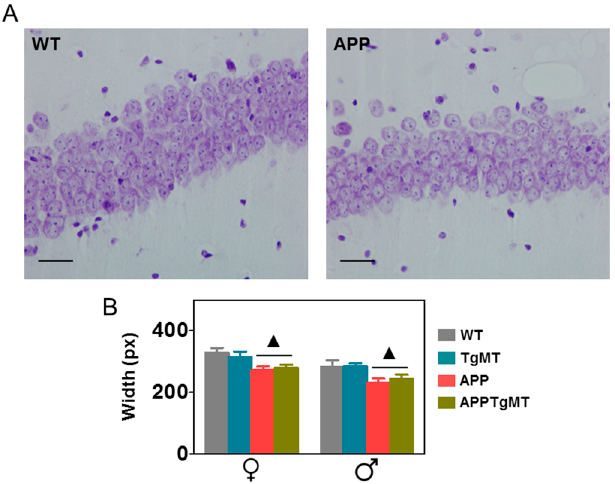
Figure 5. Effect of Mt1 overexpression on hippocampal CA1 neurons. ( A ) Representative histochemistry of Nissl body staining of neurons in hippocampal CA1 of WT and APPWT mice. Scale bar: 20 µm; ( B ) Quantification of the thickness of the CA1 layer indicated a significant decrease in APPWT and APPTgMT mice in both sexes, whereas no significant effects of Mt1 overexpression were observed. Results are mean ± SEM ( n = 11–18); ▲ p < 0.01 vs. APP negative mice.